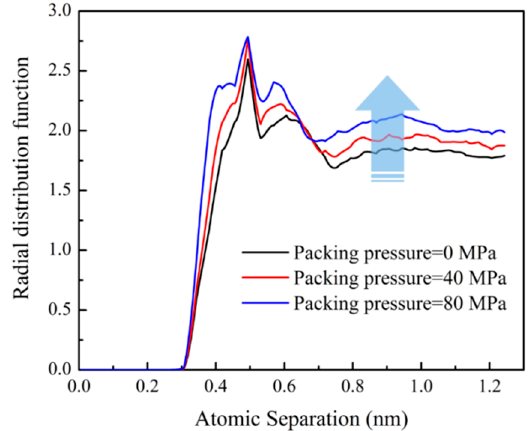
Figure 6. The radial distribution function of carbon atoms in the PP layer with respect to nickel atoms.